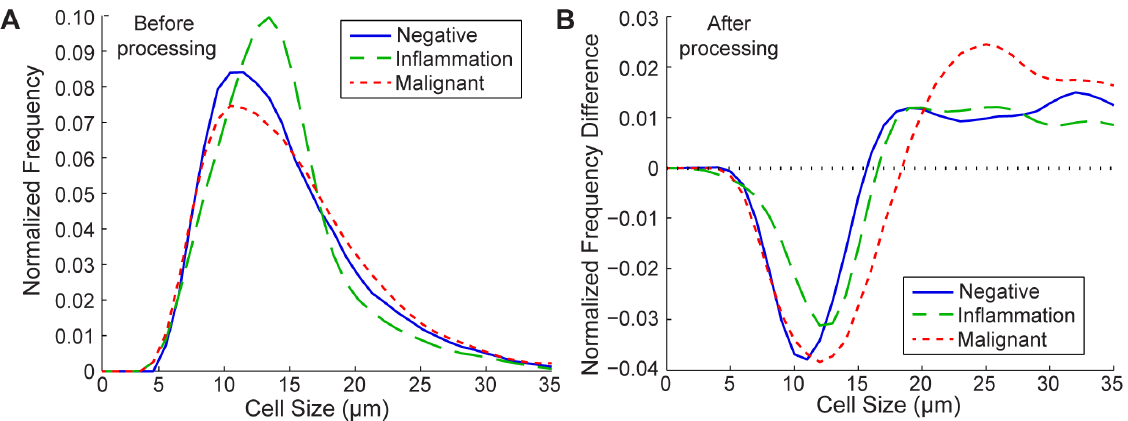
Figure 2. Distribution of Cell Size in Pleural Fluids and Enrichment with the Centrifuge Chip. (A) Normalized frequency distributions of nucleated cells in relation to cell diameter are plotted for pleural effusions analyzed within 24 hours of collection and diagnosed as negative (blue, solid), inflammation (chronic and acute, green, dashed), or malignant (red, dotted). Relative to negative pleural effusions, malignant samples contain a larger population fraction of cells greater than 15 m m, and cases of inflammation contain a larger population of cells between 10–15 m m. N=13, 9, and 10 for negative, inflammation, and malignant cases. (B) The frequency distributions of the same samples after processing through the Centrifuge Chip were subtracted by the distributions before processing to observe enrichment. The device enriches for cell populations greater than 15 m m and